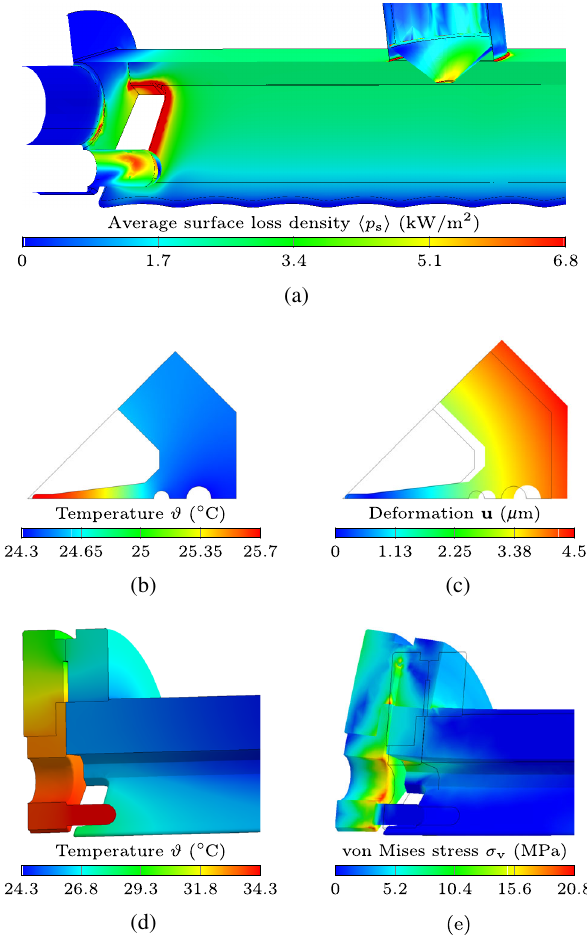
FIG. 13. Thermal simulation results for nominal operation para- 22 ° C, meters: duty cycle d ¼ 2 . 5% , water temperature ϑ w ¼ 1 m = s. Figure (a) shows the surface loss density flow speed v FIG. 14. Shift of the resonance frequency of the RFQ cavity w ¼ on the output end, cavity wall and tuner tip (maximum value cut subject to heat-induced deformation due to rf surface losses, with off for visualization purposes). The resulting temperature dis- linear dependence on water temperature and flow velocity within tribution is shown in (b) and (d). Figures (c) and (e) depict the the area of RFQ operation. The effect of reducing the water flow corresponding deformation and equivalent stress. velocity is comparatively